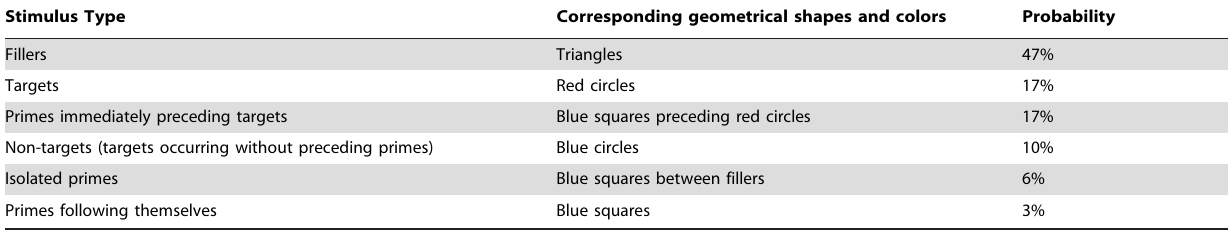
Table 1. Probabilities of the stimuli in the CTR condition.